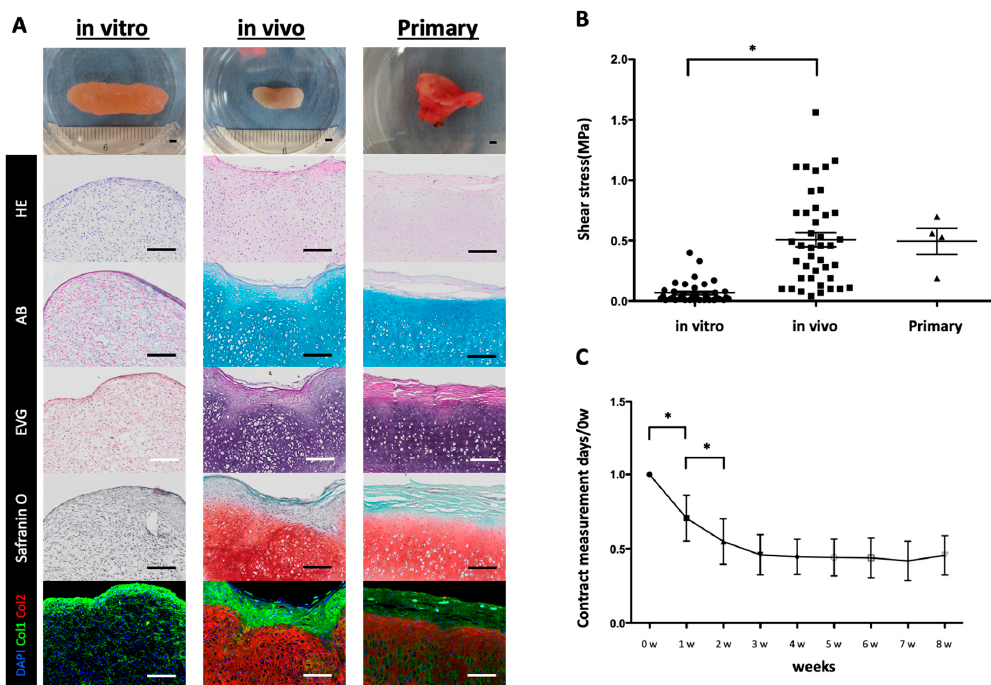
Figure 4. Transplanted elastic cartilage tissue showing maturation. ( A ) Macroscopic images, along with hematoxylin and eosin (HE), Alcian blue (AB), elastica–van Gieson (EVG), safranin O, DAPI, collagen type I (Col1), and collagen type II (Col2) staining of elastic cartilage tissue after RWV culture (in vitro), transplanted elastic cartilage tissue (in vivo), and primary cartilage. Scale Bars: 200 μ m. ( B ) Shear stress values of cultured elastic cartilage tissue (in vitro), transplanted elastic cartilage tissue (in vivo), and primary cartilage. Holm–Sidak multiple comparisons test: * p < 0.01 vs in vivo samples ( n = 4–41) ( C ) Appearance scale changes over time up to 8 weeks after transplantation. Holm–Sidak multiple comparisons test: * p < 0.01 vs. 1 and 2 w after transplantation ( n = 22–28).